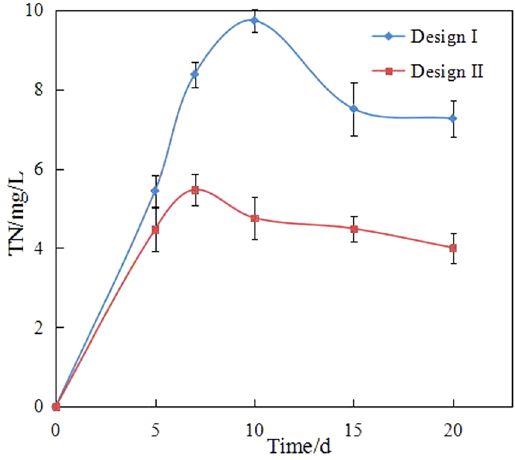
Figure 7. The concentration of TN.